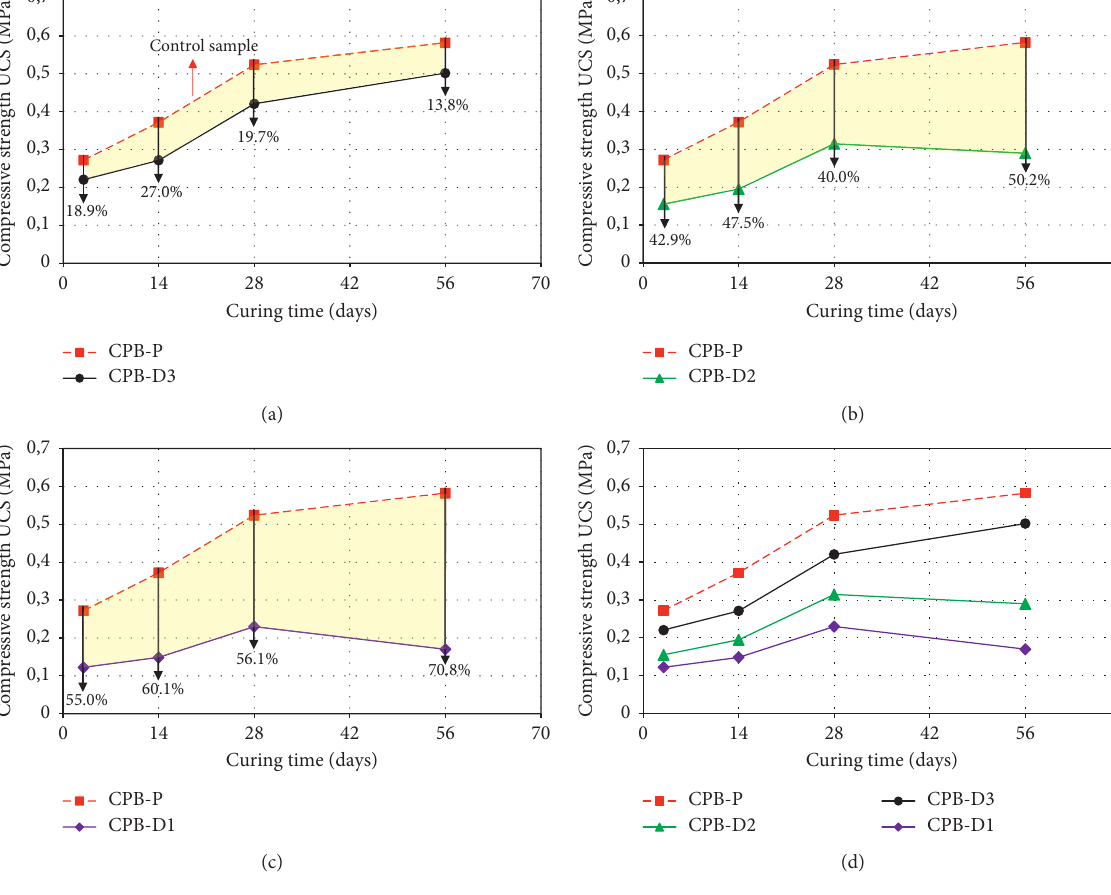
Figure 3: Change in UCS with time for diverse mine backfills.